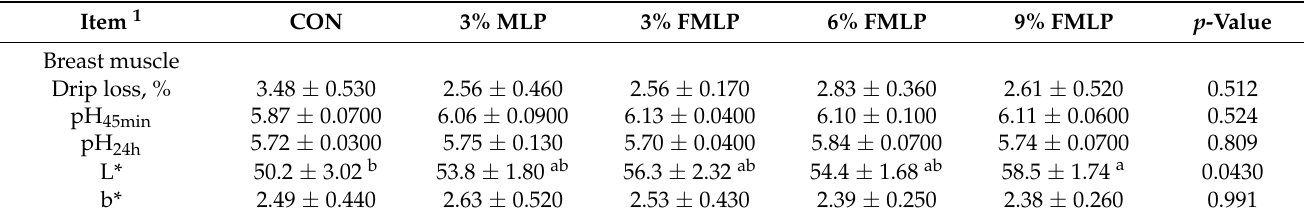
Table 8. Effects of FMLP on breast and thigh meat quality of